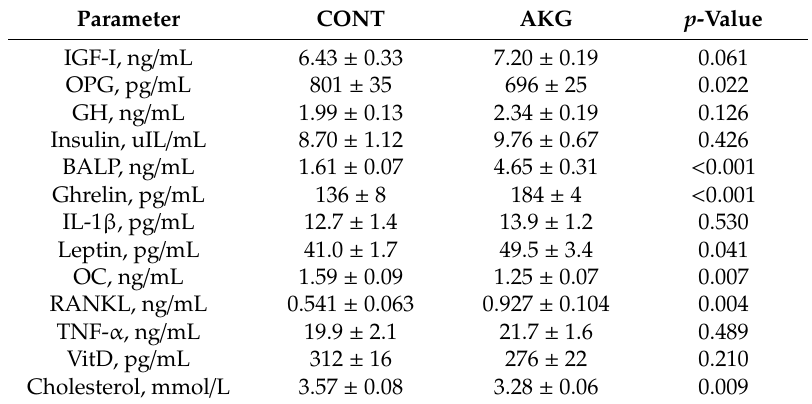
Table 3. The influence of AKG supplementation during the experimental period (31–60 weeks of age) on blood serum biochemistry in laying hens at the age of 60